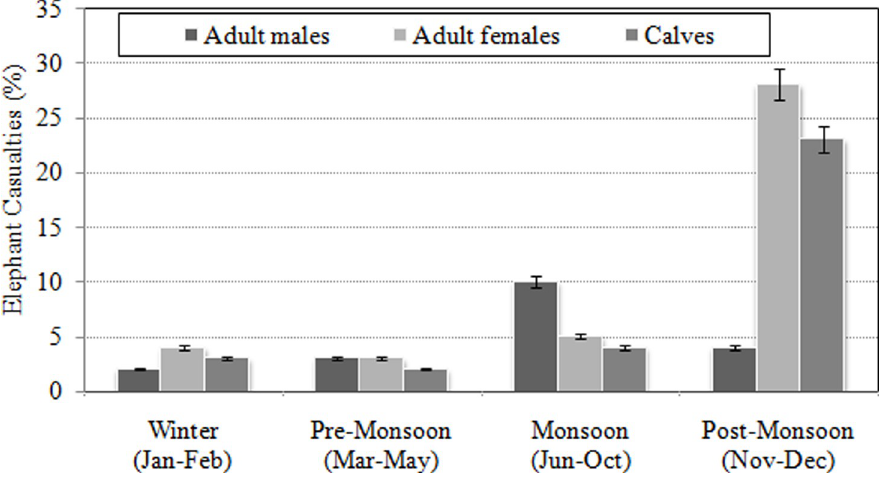
Fig 6. Variation of age and sex specific elephant casualties from train collisions in relation to climatic